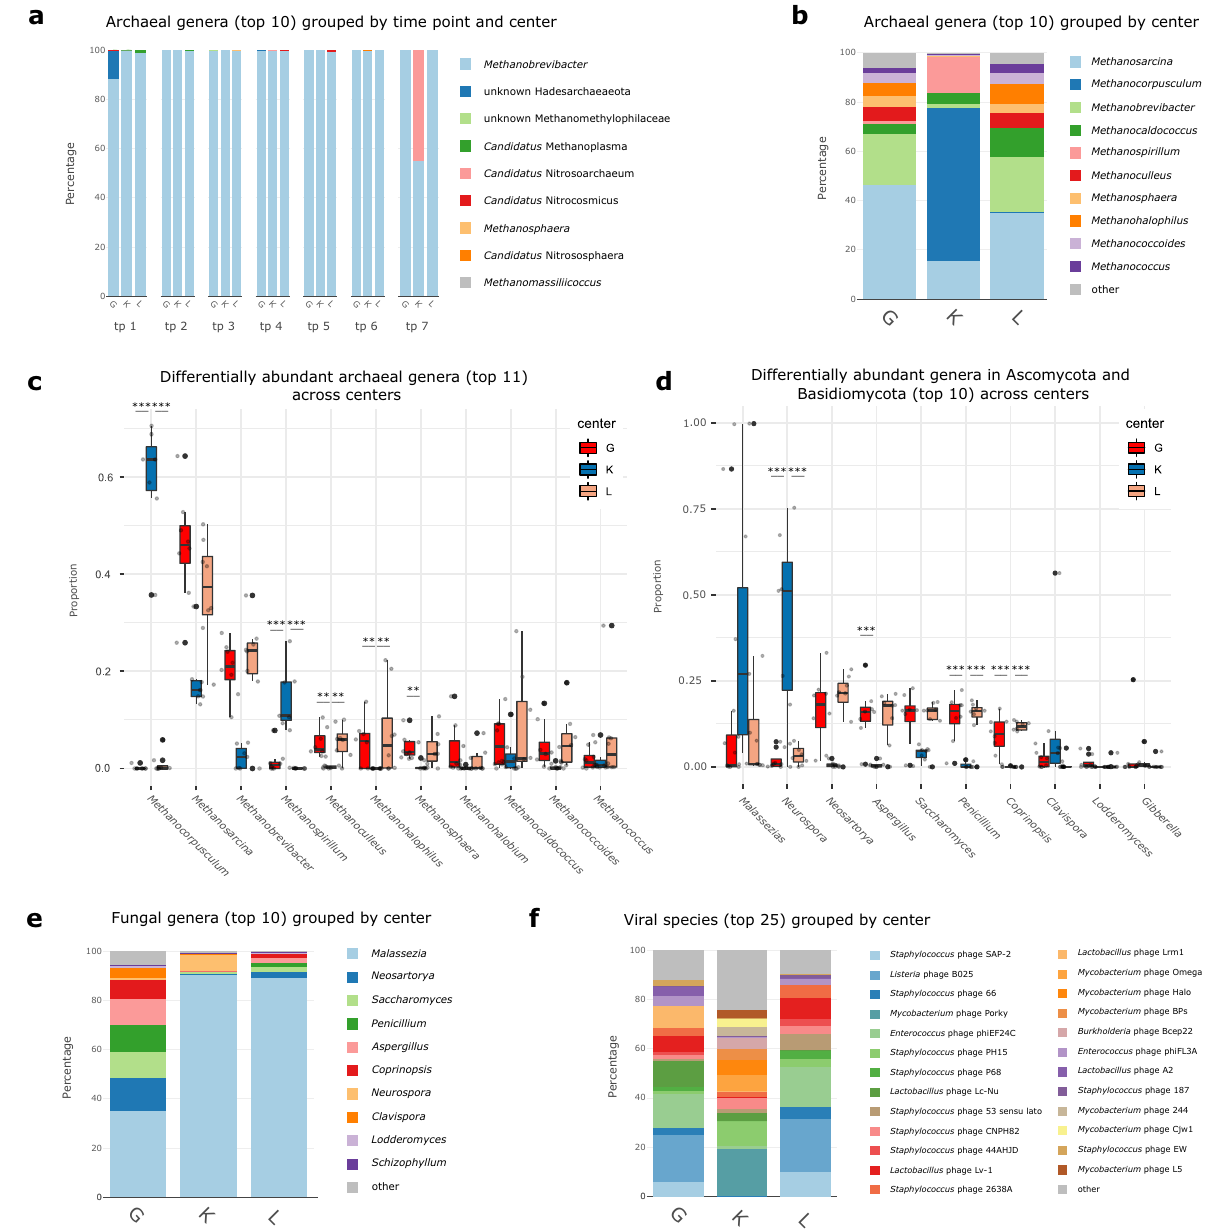
Fig.1|Overalldistributionandabundancesofmicrobialsignaturesofdifferent domains, according to the different centers. a Stacked bar plot of relative abundances of the top ten archaeal genera in the amplicon data set, displayed per center at time points (tp) tp1 – 7. b Stacked bar plot of the top ten relative abun- dancesofmethanogenicarchaealgeneraintheMGS(metagenomic)datasetfortp7 per center. c Box plot of relative abundances of the top eleven methanogenic archaeal genera per center (MGS data, tp7, n =23 biologically independent sam- ples, DSeq2): Methanocorpusculum : K:G q <0.001, K:L q <0.001, G:L q =0.945; Methanosarcina : K:G q =0.261, K:L q =0.054, G:L q =0.945; Methanobrevibacter : K:G q =0.052, K:L q =0.138, G:L q =0.945; Methanospirillum : K:G q <0.001, K:L